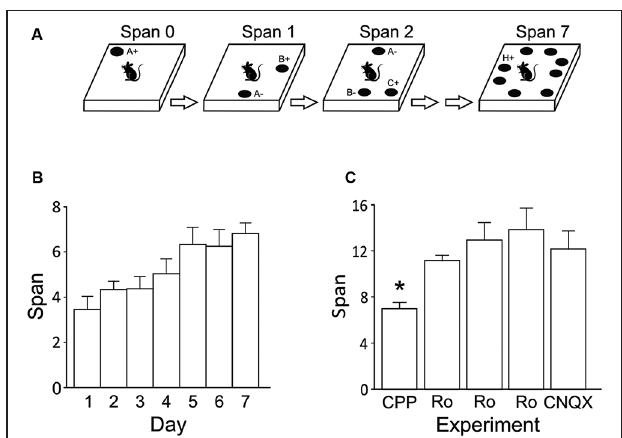
FIGURE 1 | (A) Illustration of the OST. See text for details. Odors are indicated with letters. On subsequent trials for a given span, the bowl (black circle) that contains the novel odor is rewarded ( + ) while all previously encountered stimuli are not ( − ). Bowls are added one at a time to the platform until an error is made. The span is calculated as the number of bowls on the platform for the last error free trial minus 1. Note that all bowls are moved around the platform before each new trial. (B) Mean odor spans during the 7 days of training immediately prior to the first treatment (3-(2-Carboxypiperazin-4-yl)propyl-1-phosphonic acid (CPP); n = 8). (C) Mean odor spans on the baseline sessions before each treatment in the within subjects design (see Table 1 ). The GluN2B-selective NMDA receptor antagonist Ro 25-6981 was given three times: first, 6 mg/kg (i.p.); second, 10 mg/kg (i.p.); and third, 2.5 μ g/hemisphere. * Refers significantly lower span relative to all other conditions ( p < 0.05). Ro, Ro 25-6981.